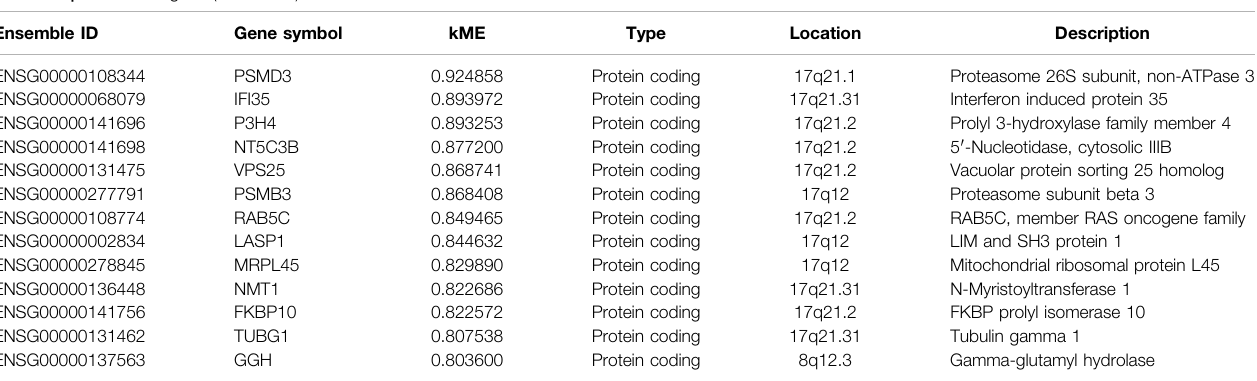
TABLE 3 | RS module gene (kME > 0.8) from